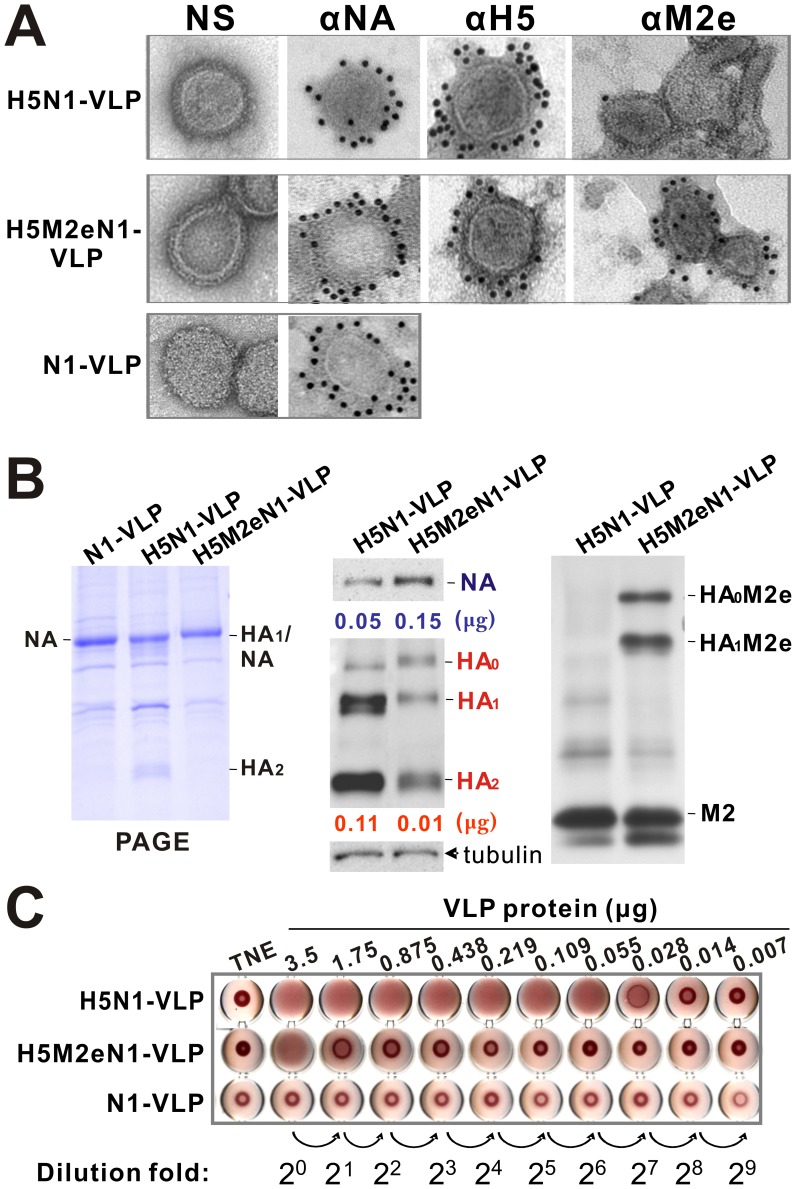
Comparative characterizations of N1-based VLPs with their prototyped H5N1-VLP.(A) Secreted VLPs of different designs are as indicated to the left of panels. Purified VLPs were adsorbed onto formvar/carbon-coated nickel grids. NS, negatively stained with 2% uranyl acetate; immunogold stained with specific antibodies as marked on the top. The secondary antibodies were goat anti-rabbit or anti-mouse conjugated to 12 nm gold beads. The grids were observed by TEM at 100,000× magnification. (B) Western blot analysis of virus-specific proteins in VLPs. Equal amount of VLPs were separated on a 7.5–12.5% gradient gel followed by Coomassie blue staining or western blot analysis with specific antibodies. Identity of viral proteins in the VLPs were detected and labeled on the right. The same blot was probed with anti-tubulin antibody as a loading control of VLP preparations. Middle, the HA and NA amount in 0.5 µg of each VLP was marked below. (C) Assessment of HA function by hemagglutination assay. The amounts of VLPs used are indicated, in a two-fold serial dilution. TNE (buffer of VLPs) was used as the negative control. The antibodies used in this study were tubulin (ab6160), N1 (ab21305), and M2e (ab5416) from Abcam (Cambridge, MA). Rabbit polyclonal antibody against H5 was provided by Dr. Che Ma (Genomics Research Center, Academia Sinica).